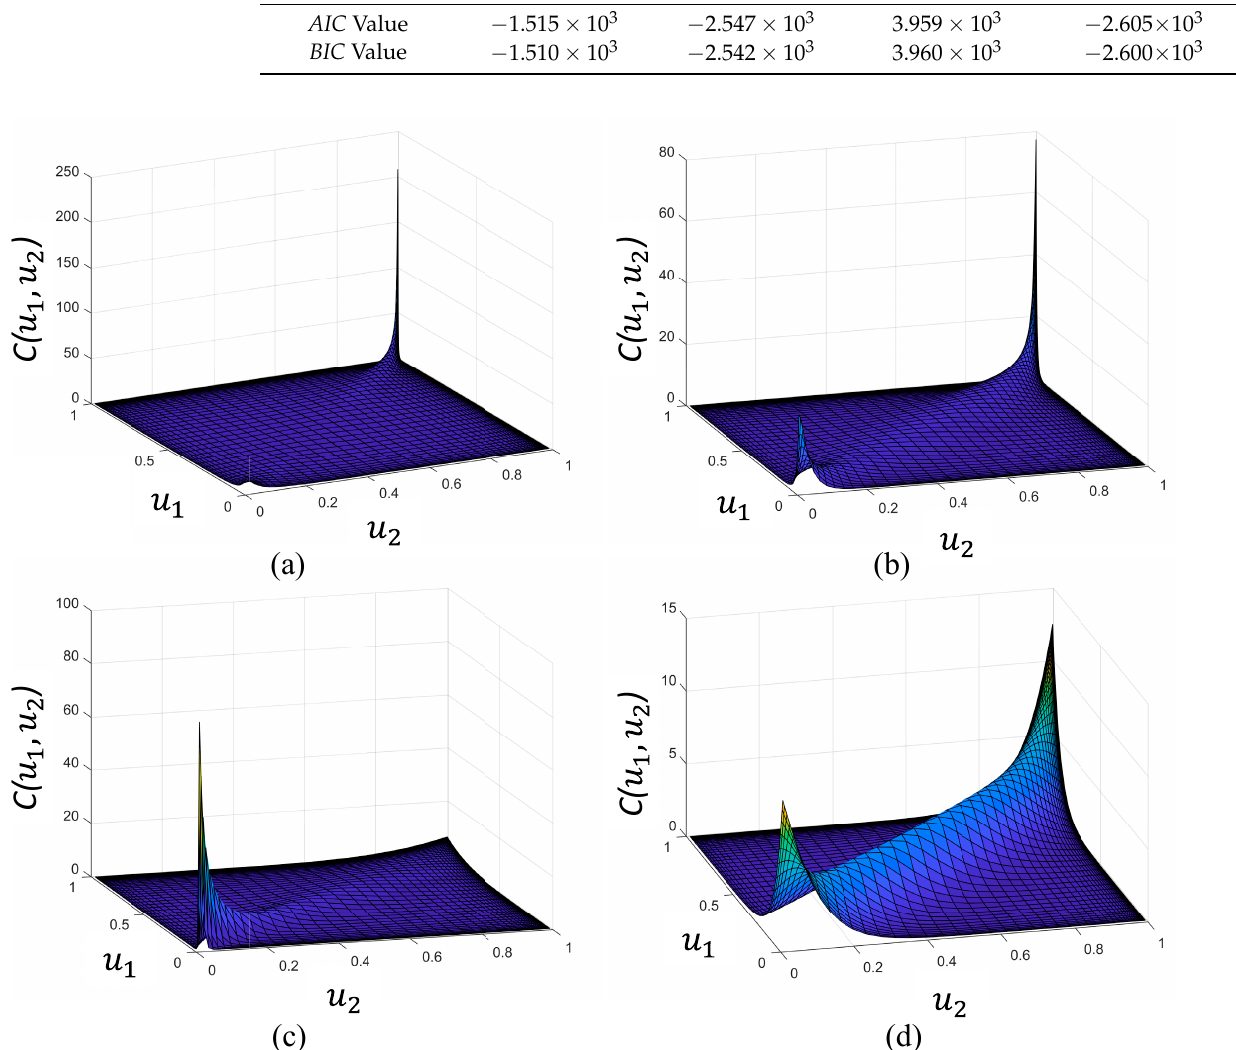
Figure 7. The 3D plot of PDF for the joint distribution by ( a ) Gumbel copula; ( b ) Gaussian copula; ( c ) Clayton copula; and ( d ) Frank copula.